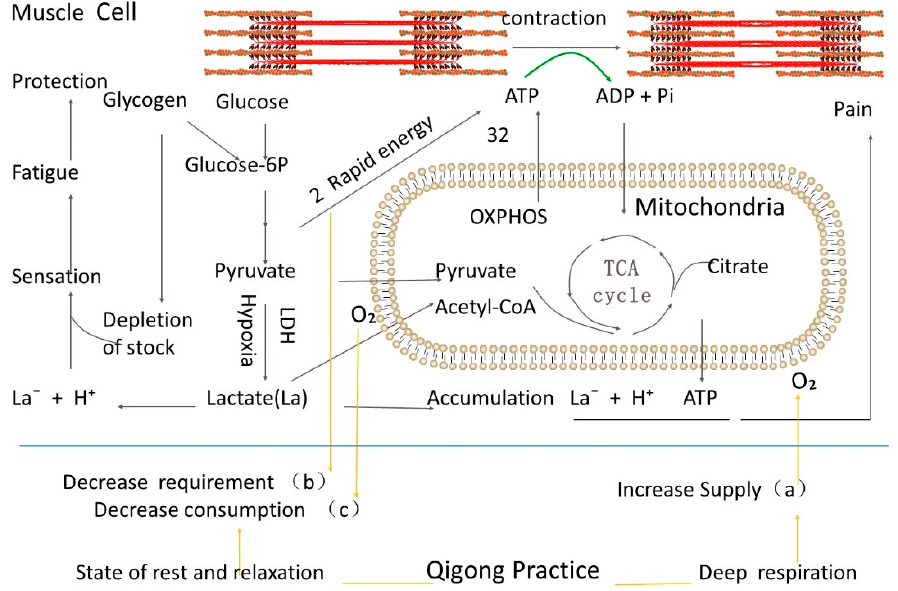
Figure 1. Schematic representation of glucose metabolism during exercise. The orange lines represent the state of Qigong practice. The blue line presents the cell membrane. Muscle contraction requires the hydrolysis of ATP, a form of chemical energy, for the actin-myosin cross-bridge cycle. Glucose and glycogen are the forms of energy stores. Glucose in the cells is phosphorylated into glucose-6-phosphate (glucose-6P). Glucose-6P is then metabolized through glycolysis to produce two pyruvate molecules and two rapid-energy ATP molecules. Two pyruvate molecules can enter mitochondria, which are metabolized through the tricarboxylic acid (TCA) cycle and oxidative phosphorylation to produce 32 more ATP molecules when oxygen is available. Pyruvate can otherwise be reduced into lactate-by-lactate dehydrogenase (LDH) when the cells are under the hypoxia condition, and a process is called glycolysis. So the complete oxidation of glucose produces much more molecules of ATP in the mitochondria (32 ATP) than in glycolysis (2 ATP). The slow ATP production in mitochondria and shortage of oxygen supply during exercise drives glucose metabolism through glycolysis for rapid energy. Under hypoxia, the metabolite pyruvate is converted into lactate by LDH. The low efficiency of ATP production in glycolysis results in the rapid depletion of energy stock glycogen and lactate accumulation. Lactate accumulation and its existence as La − and H + play a role in fatigue sensation for tissue protection and the signal of tissue disorders such as pain. Through training deep respiration and keeping our body in a state of relaxation, Qigong practice improves the hypoxia state of the tissue in three ways: (a) by Increasing the supply of oxygen; (b) by decreasing the requirement of rapid energy; (c) decreasing the consumption of